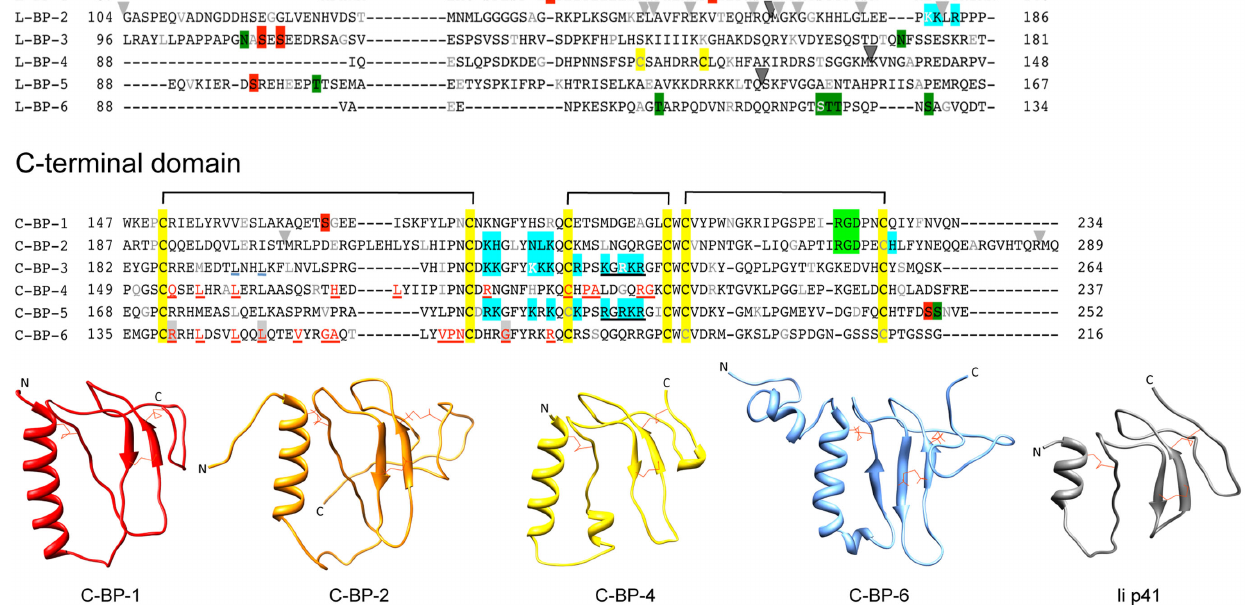
FIGURE 1 | Sequences and structures of IGFBP domains. Sequence alignments of IGFBP-1 to-6 N-terminal (N-), linker (L-), and C-terminal (C-) domains, highlighting cysteine residues (yellow box) and the disulfide bonding connectivity (black lines above and below sequences). Residue numbers are shown next to the sequences and every 10th residues is gray or white.The following distinctive features are highlighted: Red underlined text highlights IGF binding residues defined in structural studies of the N-domain [IGFBP-4 (Sitar et al., 2006) and mini IGFBP-5 (Kalus et al., 1998)] and C-domain [IGFBP-4 (Sitar et al., 2006) and IGFBP-6 (Headey et al., 2004a)]. Open red boxes, key residues involved in binding conserved across all IGFBPs; Light gray arrowheads, IGFBP-2 proteolysis sites (Ho and Baxter, 1997; Rehault et al., 2001; Monget et al., 2003; Standker et al., 2003; Mark et al., 2005; Berg et al., 2007; Miyamoto et al., 2007); Dark gray arrowhead, PAPP-A cleavage sites on IGFBP-2, -4, and -5 (Conover et al., 1995; Laursen et al., 2001;